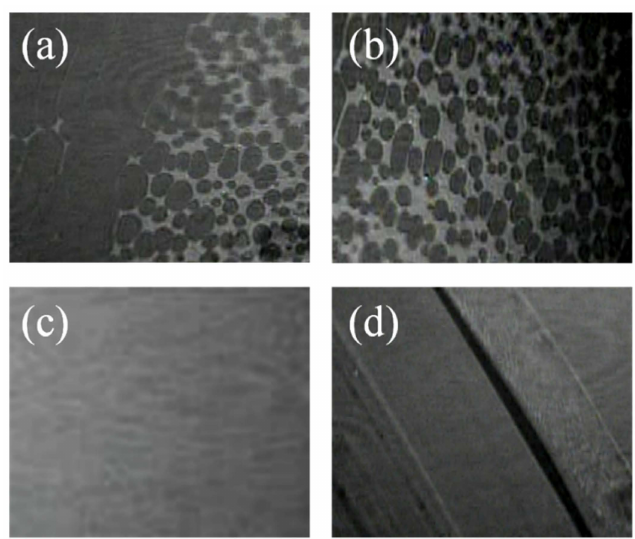
Figure 7. BAM images (width: 500 µ m) of the 2b compound at different surface pressures: ( a ) 0.5 mN ¨ m ´ 1 , ( b ) 5.0 mN ¨ m ´ 1 , ( c ) 10.0 mN ¨ m ´ 1 , and ( d ) 25.0 mN ¨ m ´ 1 . Langmuir Isotherm for the 4b Complex